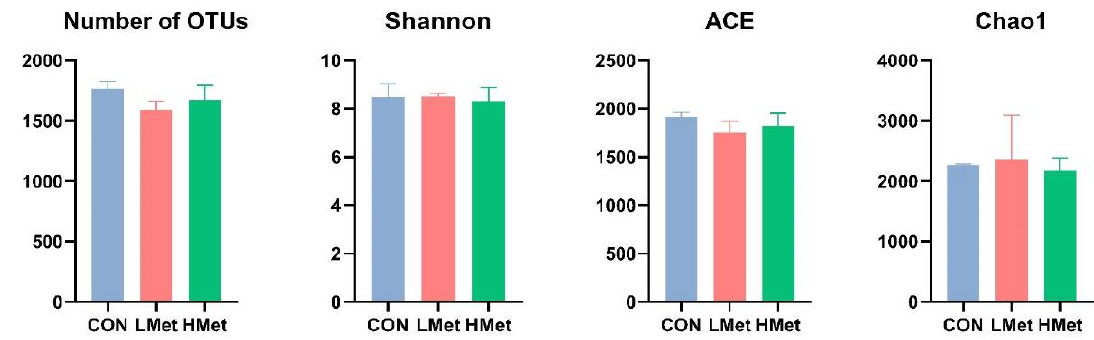
Figure 2. Comparisons of the alpha diversity of the bacteria in the rumen of sika deer.